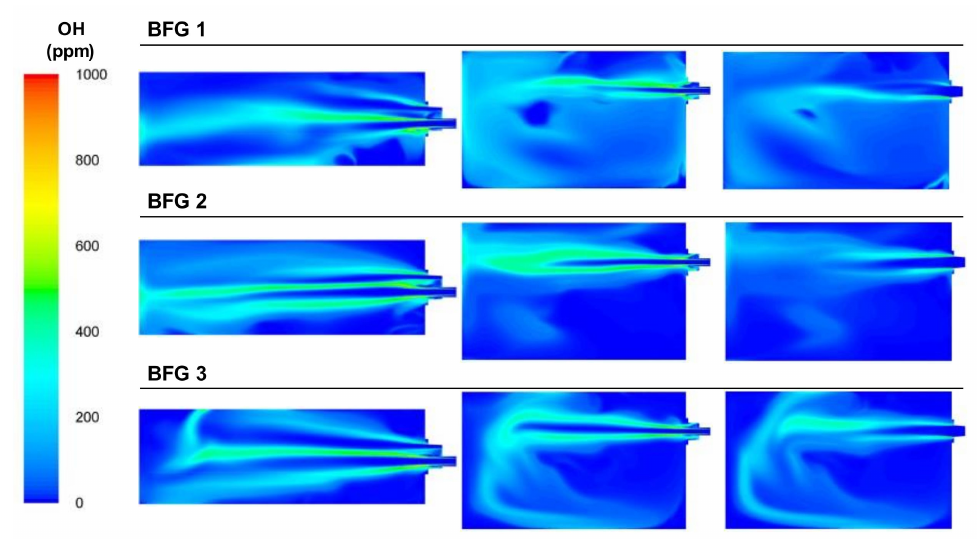
Figure 13. Contour plots of OH concentrations for the BFG cases in the XZ1, XY1, and XY2 planes. Regarding the oxygen concentration, Figure 14, which includes the plots of the oxygen concentration from the analysis sections, shows that the oxygen that left the burner area without participating in the combustion processes decreased in the cases with lower air flows. This was reflected in the final concentration of oxygen in the exhaust gas area.